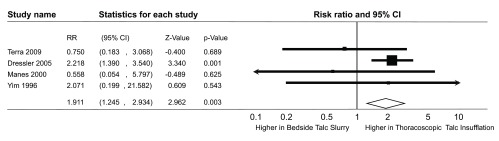
Pooled relative risks (RRs) for respiratory complications post talc pleurodesis.
RR,
risk ratio,
CI, confidence interval.